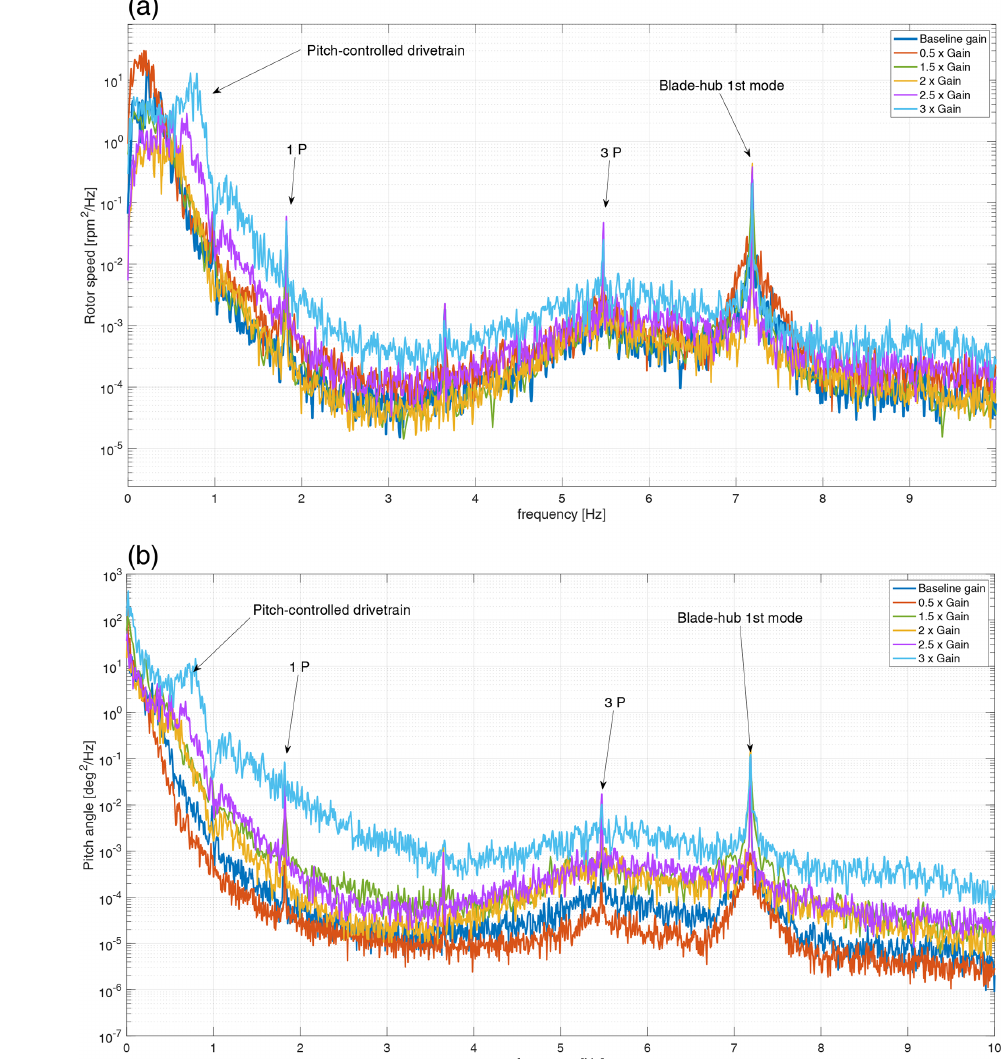
Figure 15. PSD of the rotor speed (a) and blade pitch (b)